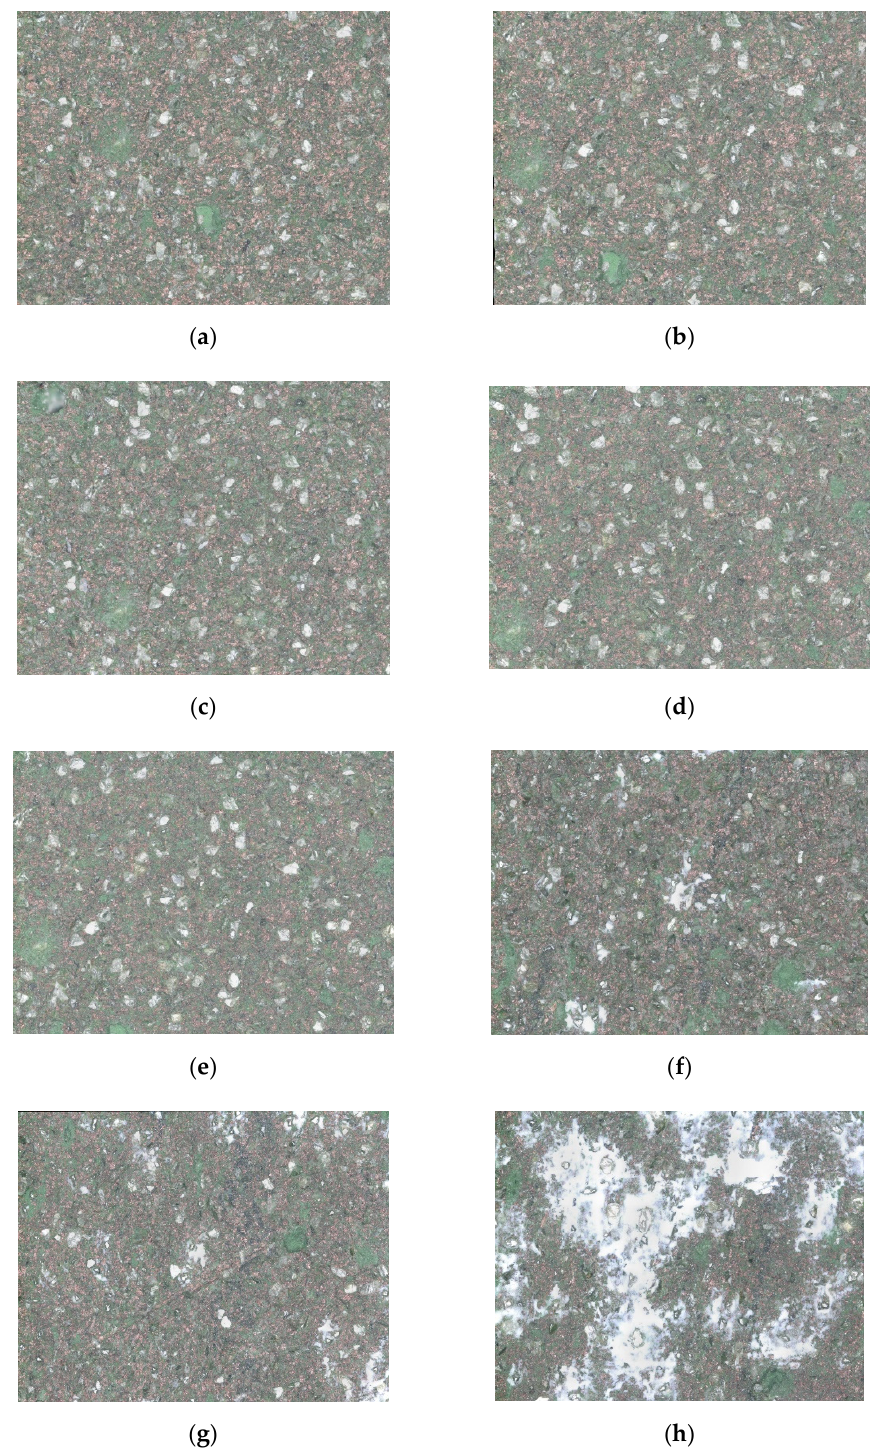
Figure 2. Wheel topography evolution during grinding. ( a ) the 1st node; ( b ) the 3rd node; ( c ) the 5th node; ( d ) the 9th node; ( e ) the 13th node; ( f ) the 15th node; ( g ) the 17th node; ( h ) the 19th node